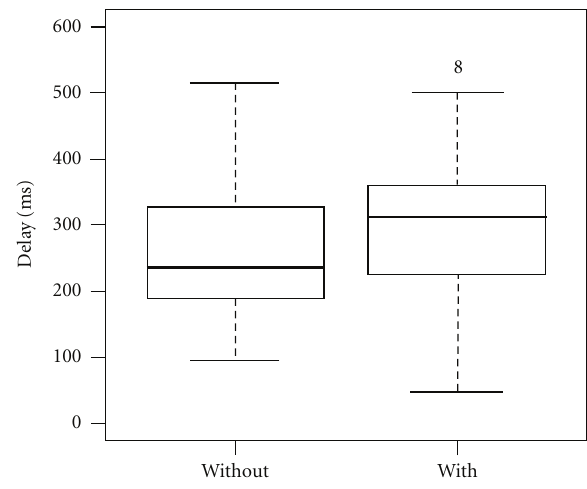
Figure 9: Distribution of call establishment